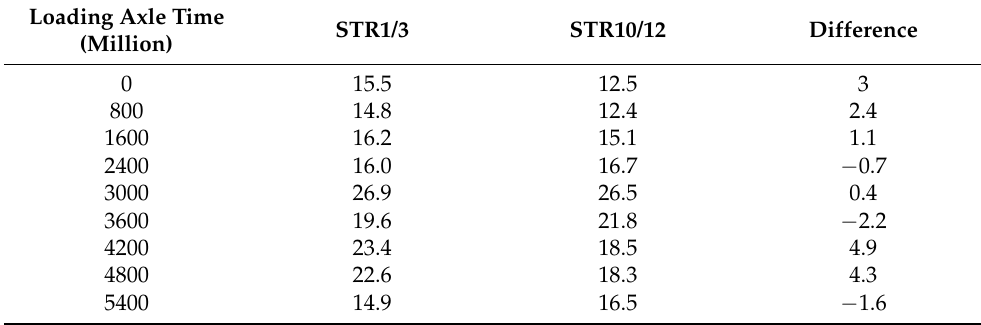
Table 5. Comparison of STR1/3 and STR10/12 characteristic temperature T 4 .